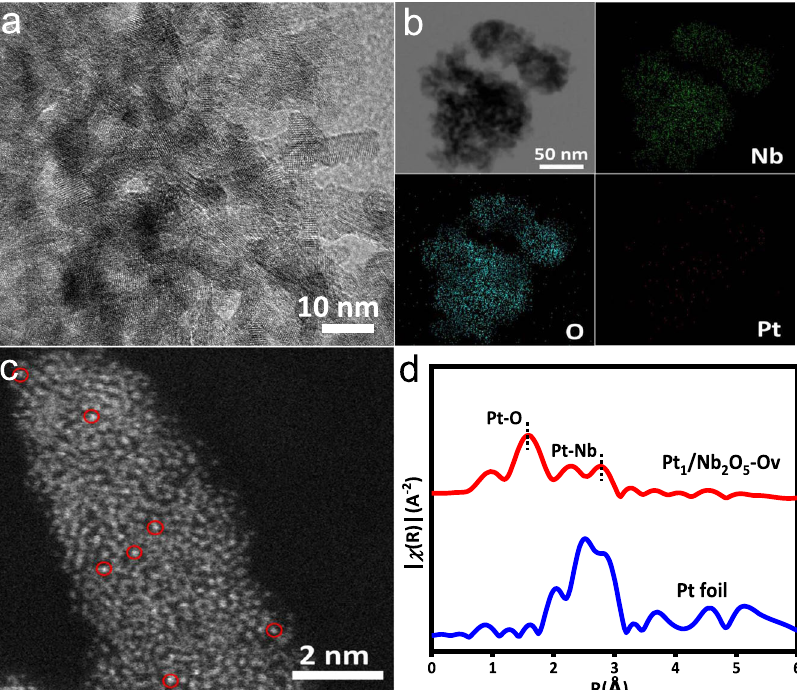
Fig. 2 The structural characterization of Pt 1 /Nb 2 O 5 -Ov. a TEM images of Pt 1 /Nb 2 O 5 -Ov. b EDS mapping images of Pt 1 /Nb 2 O 5 -Ov. c AC – HAADF – STEM image of Pt 1 /Nb 2 O 5 -Ov. The atomically dispersed Pt atoms are highlighted by red circles. d The k 2 -weighted Fourier transform spectra of Pt 1 /Nb 2 O 5 -Ov and Pt